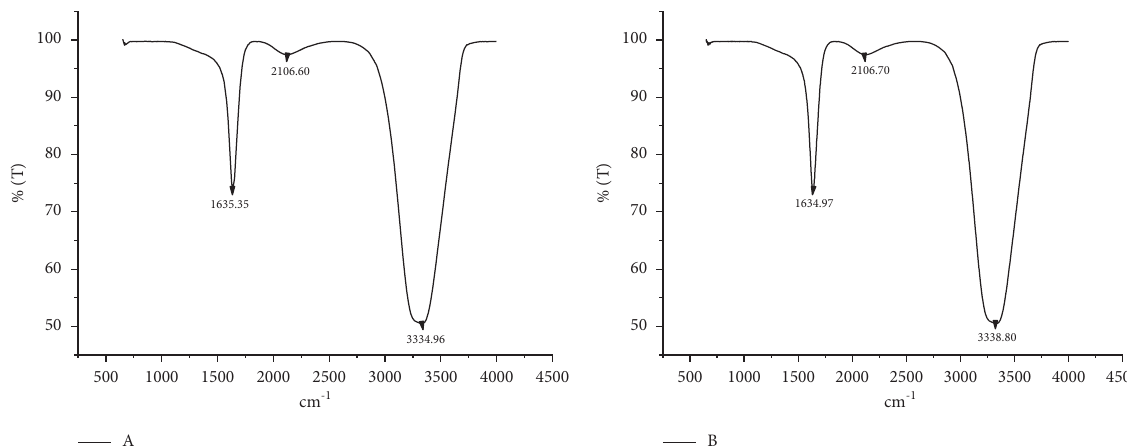
Figure 2: Evaluation of functional groups that play a role in the reduction in plant extract with FTIR spectral analysis data. (a) Ananas comosus fruit peels; (b) green synthesized AgNP pattern.